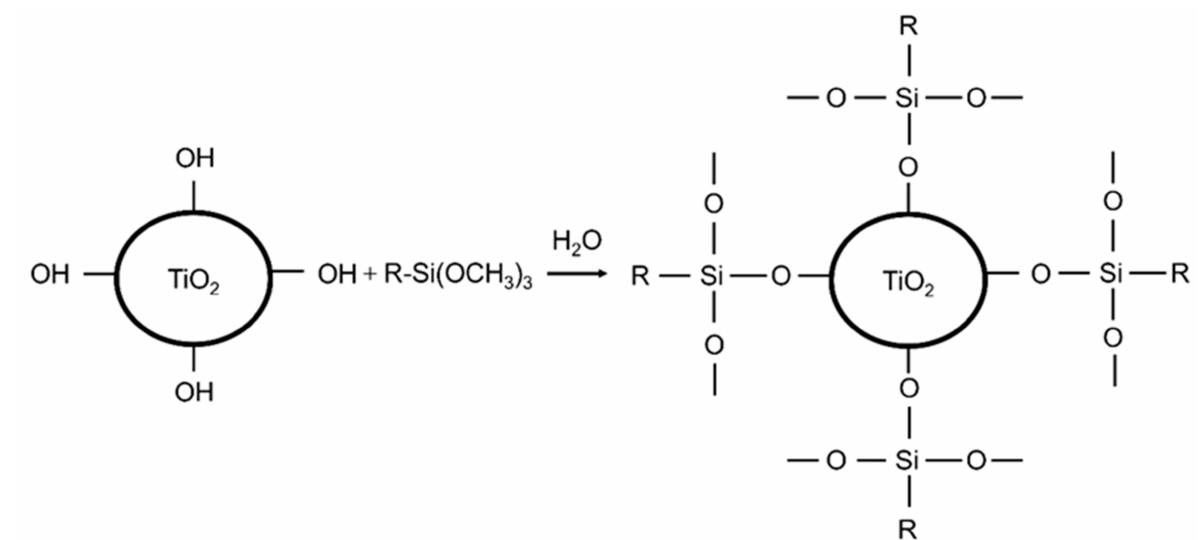
Figure 1. Alkane modification of nanostructured TiO 2 powder.